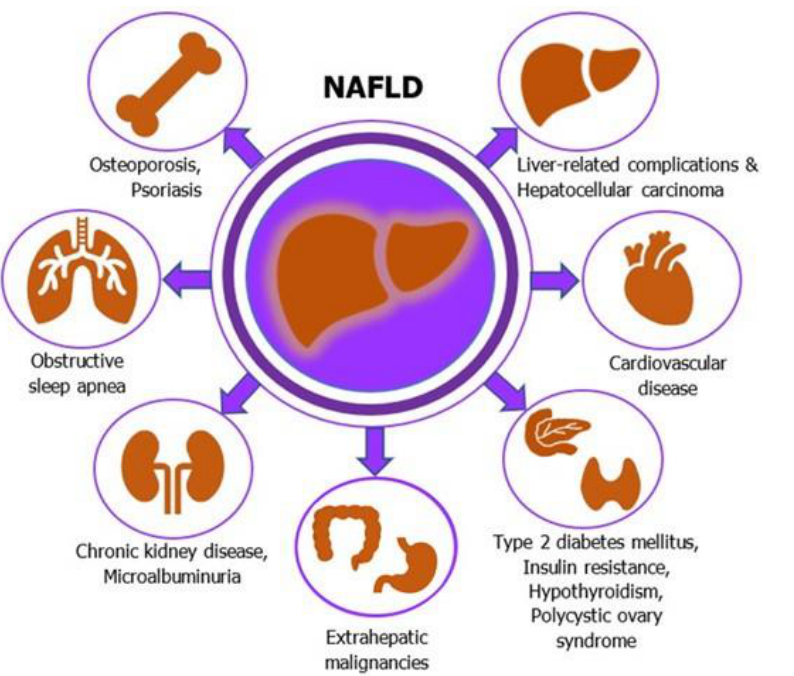
Figure 3. NAFLD is a multisystem disease leading to severe liver-related and extrahepatic complications. NAFLD — non-alcoholic fatty liver disease.